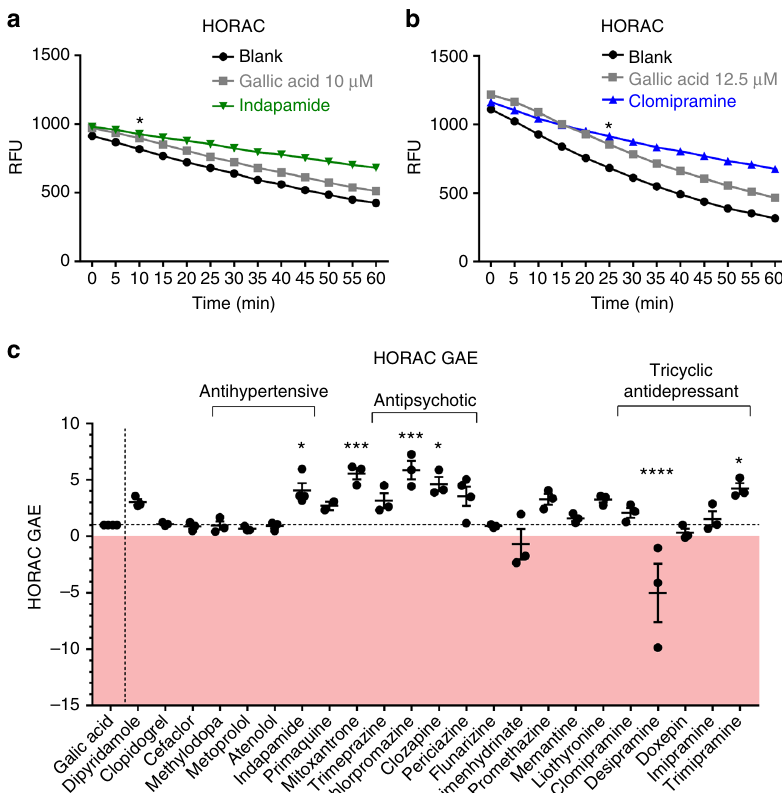
Fig. 4 Scavenging of hydroxyl radicals in a biochemical assay. The antioxidative capacities of selected compounds that reduced iron-mediated neurotoxicity were analyzed using the HORAC assay. a shows a representative experiment depicting the decay of relative fl uorescence units over 60 min for indapamide, gallic acid (GA) and the control (blank). b The upward shift of the curve for clomipramine in the HORAC assay indicates an antioxidative effect that is even stronger than gallic acid. HORAC gallic acid equivalents (GAEs) were calculated by the integration of the area under the curve of the decay of fl uorescence of the test compound over 60 min in comparison to 12.5 µ M gallic acid and blank. Shown are data of n = 3 – 4 independent experiments ± SEM, with each experiment performed in triplicates ( c ). The antipsychotics showed strong antioxidative effects, as demonstrated with HORAC GAEs of > 3. Data points > 1 represent antioxidative capacity (the gallic acid effect is 1), 0 represents no antioxidative properties, and data < 0 show pro-oxidative effect. Two-way ANOVA with Dunnett's multiple comparisons test as post hoc analysis ( a , b ); the fi rst signi fi cant time point vs. gallic acid is depicted as asterisk. One-way ANOVA with Dunnett's multiple comparisons test as post hoc analysis vs. gallic acid ( c ). * p < 0.05; ** p < 0.01; *** p < 0.001; **** p < 0.0001. RFU relative fl uorescence